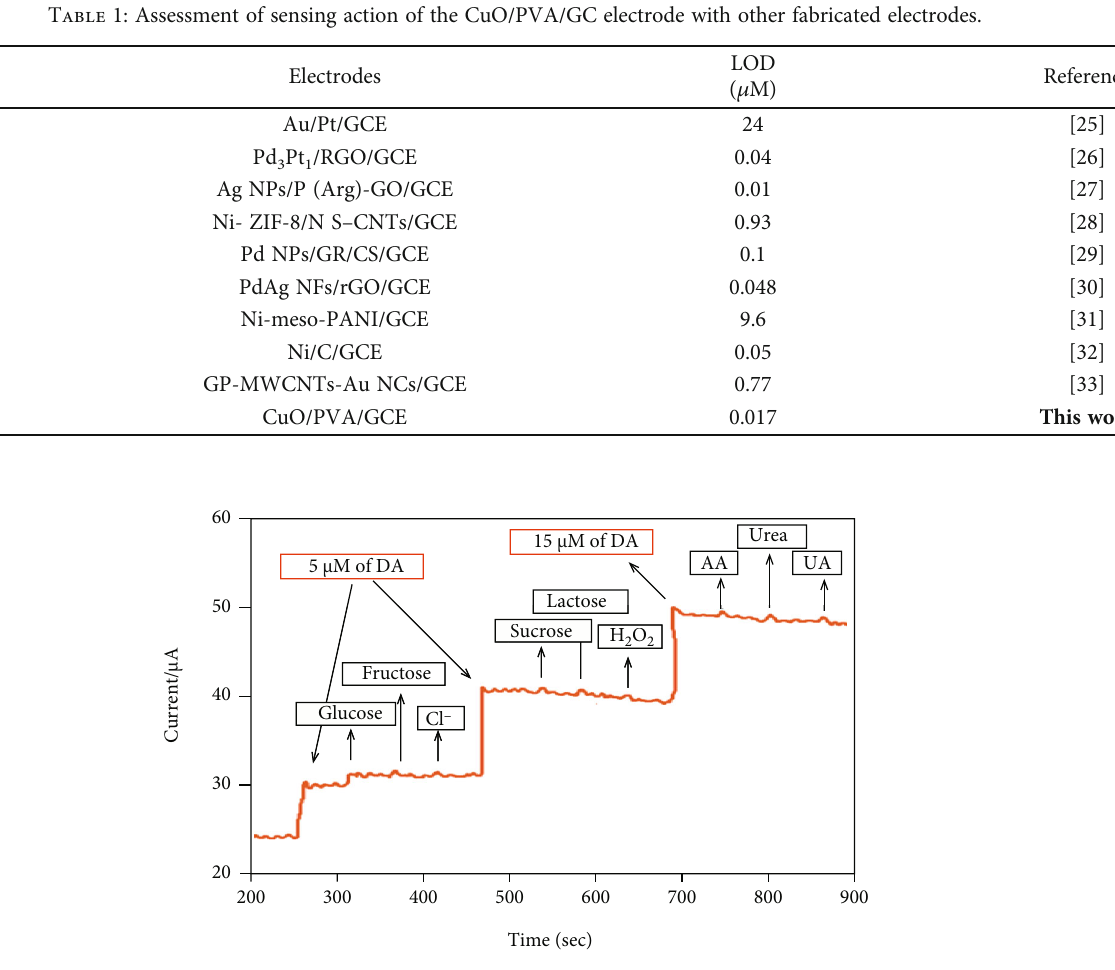
Figure 8: Amperometric detection of interfering species of the sensor in 0.1M PBS with 100 μ M of fructose, 100 μ M of glucose, 100 μ M of lactose, 100 μ M of sucrose, 100 μ M ureic acid (UA), 100 μ M of ascorbic acid (AA), 100 μ M of urea, and 100 μ M of hydrogen peroxide as well as the common ionic species potassium chloride. Table 2: Determination of DA in human urine samples using the CuO/PVA/GCE sensor (practical application of the proposed method n = 3